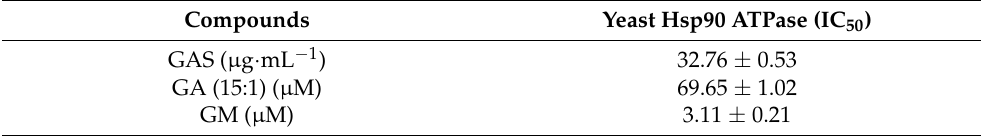
Table 1. Effect of ginkgolic acids on yeast Hsp90 ATPase inhibition using a malachite green assay.